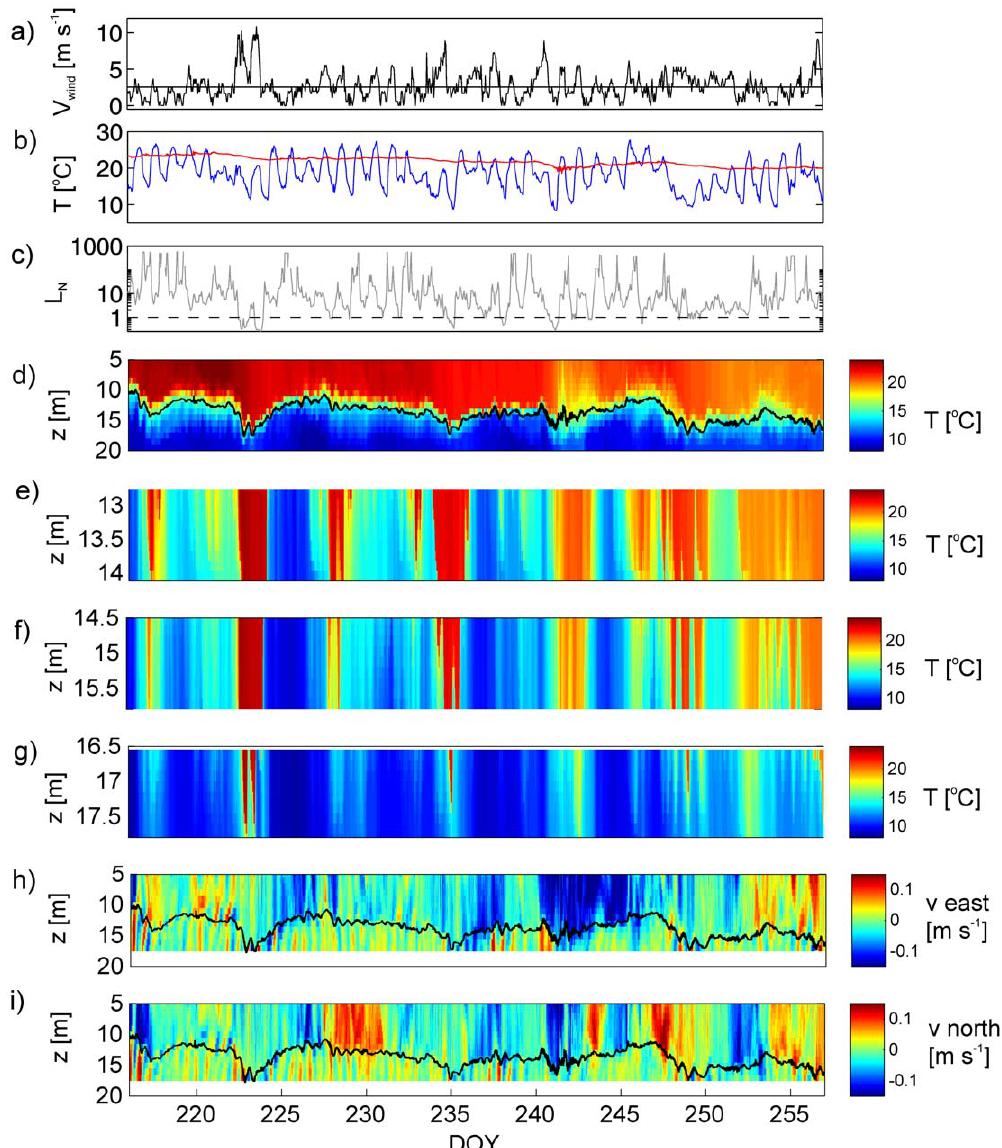
Figure 3. Observations of stratification, wind and currents in Lake Simcoe. a) Recorded wind speed at Barrie Airport. b) Comparison of air temperature (blue line) and water temperature (red line) at the top thermistor chain 5 m below the surface. c) Estimated Lake number calculated with a 12 hour moving average of wind speed and stratification, the dashed line represents a value of 1. d) The thermal stratification is shown with color contours, with the position of the thermocline at the C1 site marked in black. e-g) Temperature stratification observed at T1 to T3 during up- and downwelling of the thermocline. h) ADCP velocities east. i) ADCP velocities north.